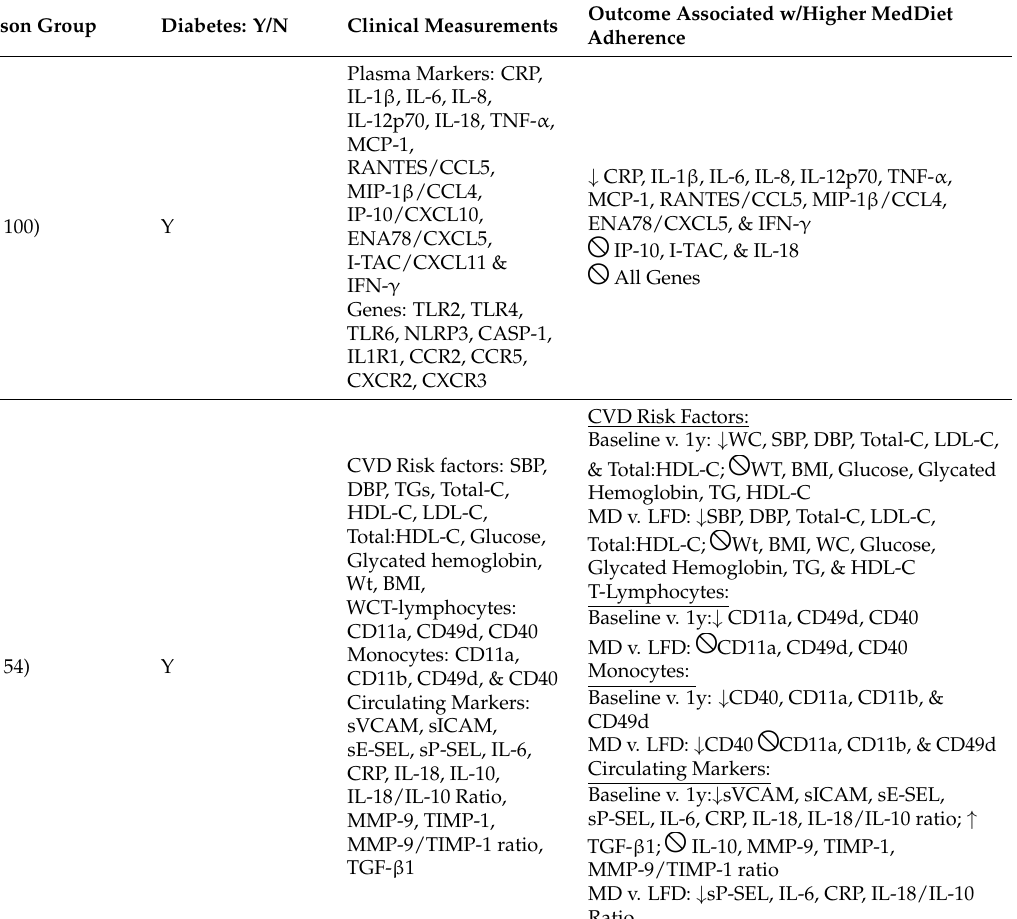
Table 2. Clinical Studies.